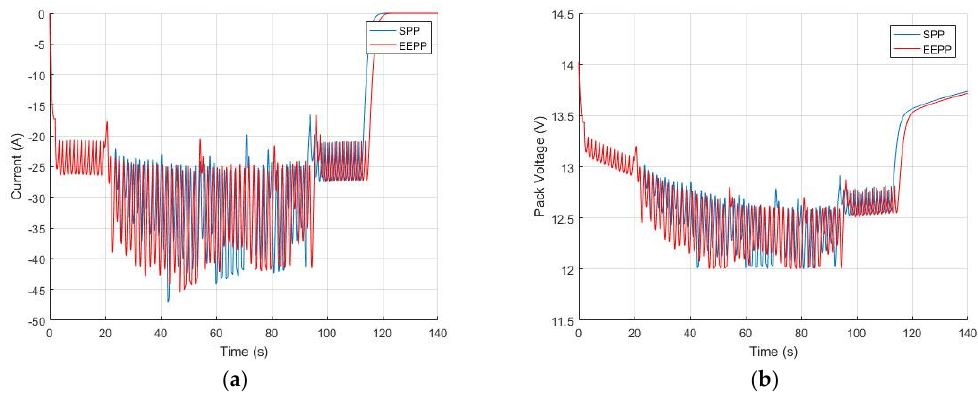
Figure 12. Current and voltage profiles (simulation): ( a ) Current profile and ( b ) voltage profile.